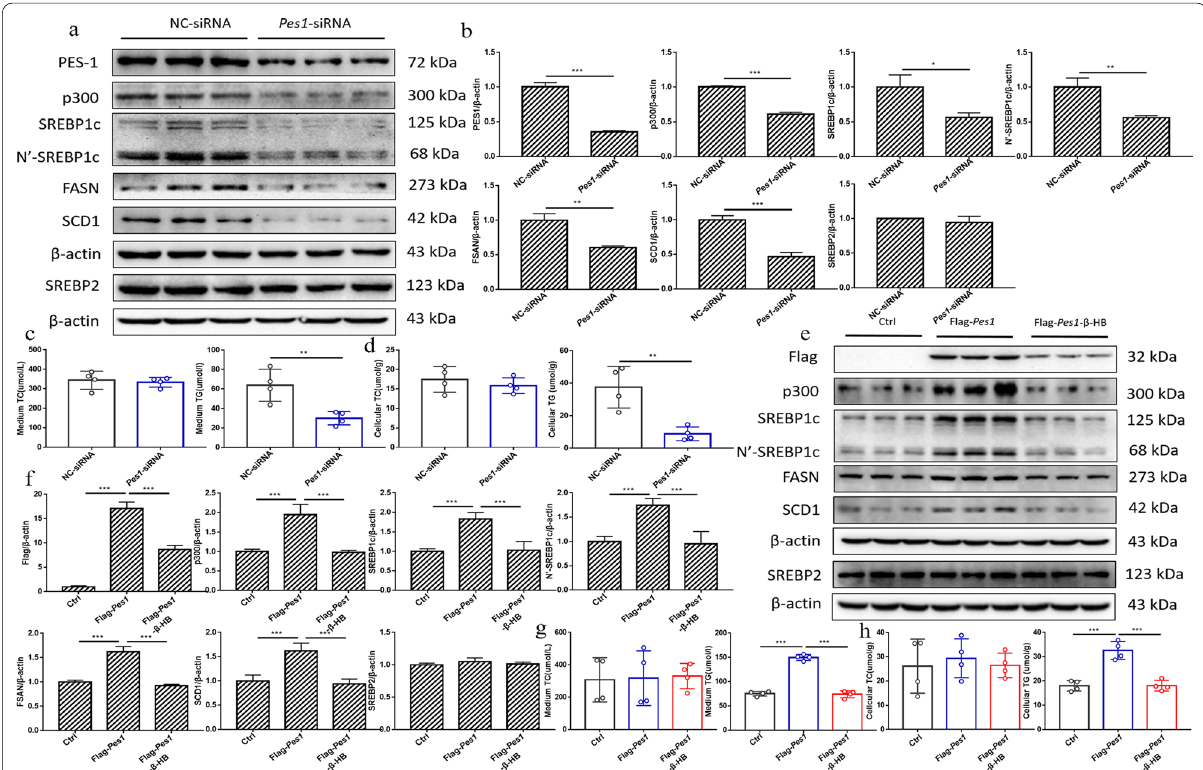
Fig. 4 Effects of Pes1 knockdown and overexpression on lipid metabolism in vitro. a , b Pes1 knockdown in cultured liver cells inhibited the protein levels of PES1, p300, SREBP1c, FASN and SCD1. c , d Displayed are the effects of Pes1 knockdown on the TG and TC levels in cultured liver cells and media. e , f Pes1 overexpression enhanced PES1-Flag, SREBP1c, p300, FASN and SCD1 protein levels in cultured liver cells, while β-HB treatment abolished the effects. g , h Exhibited are the effects of Pes1 overexpression on the TG and TC levels in cultured liver cells and media. Data were shown as mean SEM for each experiment performed independently 3 times. *P < 0.05, **P < 0.01, ***P < 0.001 compared with controls (Student’s ± t-test or ANOVA, Student–Newman–Keuls q